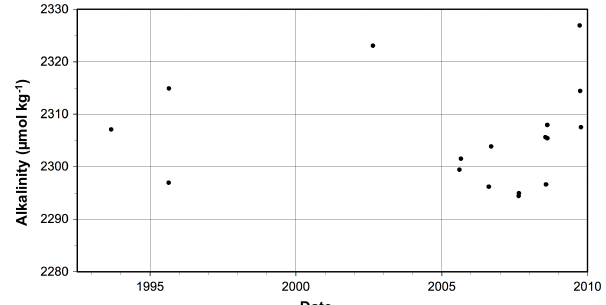
Figure 7. Alkalinity measurements from 2500 m in the central Canada